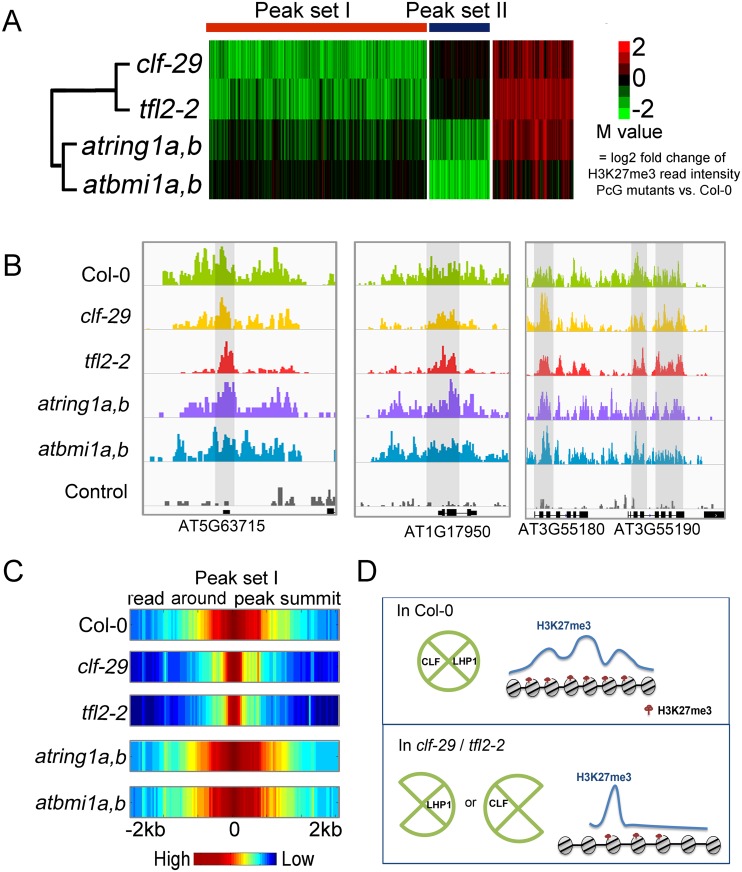
clf-29 and tfl2-2 show coordinated H3K27me3 change profiles distinct from those in atring1a,b and atbmi1a,b.K-means clustering of M values characterizing the quantitative change of H3K27me3 in PcG mutants. Definition of H3K27me3 quantitative change regions were based on combined criteria |M|>1 and P value <1e-3. Green and red colors represent lower and higher H3K27me3 levels in PcG mutants compared to that in Col-0. IGV screenshots support CLF and LHP1 participate in H3K27me3 elongation. Grey areas represent regions where significant H3K27me3 reductions happen mainly in surrounding regions but not in summit regions in tfl2-2 and clf-29 compared to Col-0. It’s worth noting that no smooth should be applied while preparing data for IGV screenshots, or else the difference between Col and clf-29 or tfl-2 would not be as obvious as the raw data. (C) Visualization of the profile of average read intensity around peak summits. All regions from peak set I were aligned such that peak summit is in the center of each region. Next, average read intensities were calculated and plotted for each consecutive 50 bp. (D) The diagram illustrates the finding based on H3K27me3 ChIP-seq data comparisons that LHP1 and CLF participate in elongation of H3K27me3 mark.